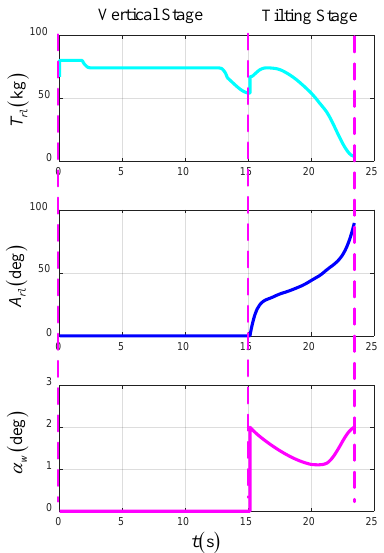
Figure 13. The state variables in VTO.